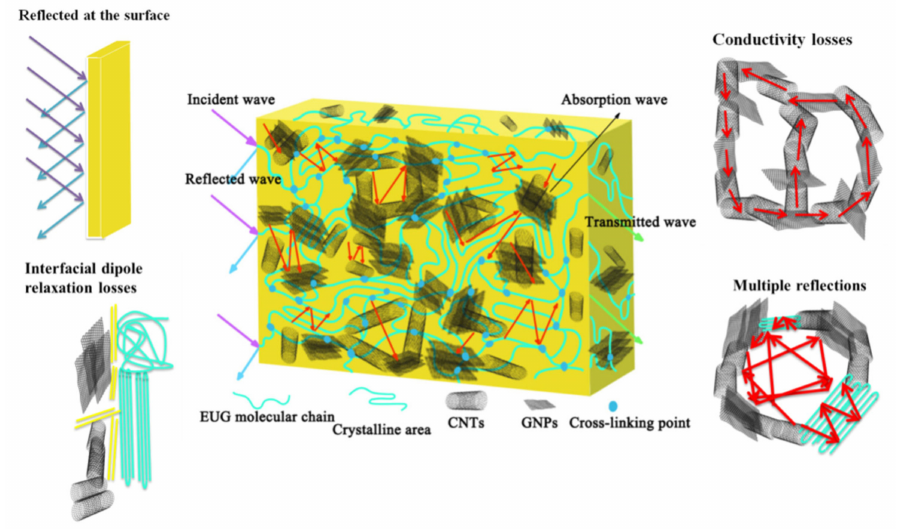
Figure 8. Proposed electromagnetic shielding mechanism for CNT/GNP/EUG composites.